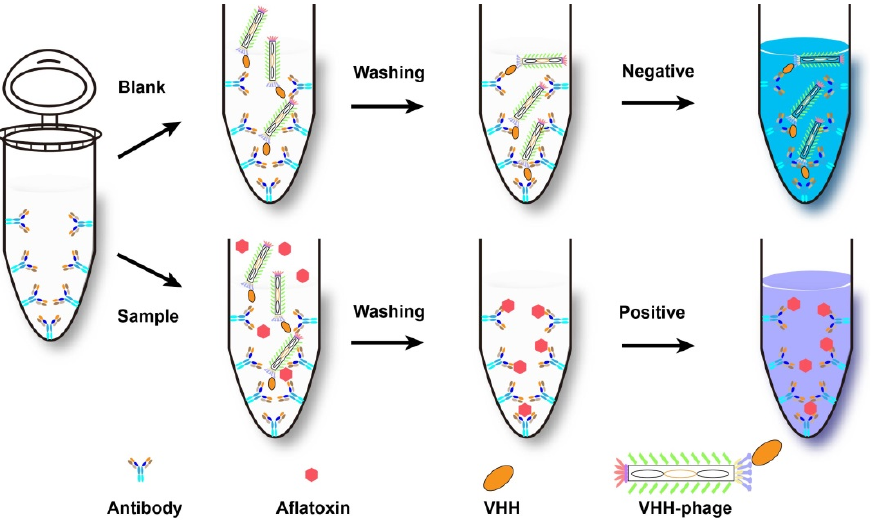
Figure 5. The detailed process of iLAMP assay (adapted from [107]).